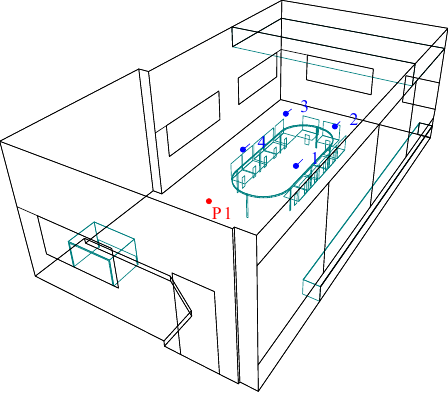
Figure 8. Source and receivers’ positions in ODEON simulations. Red color symbolizes the point source and blue color represents the receivers’ position in the room.